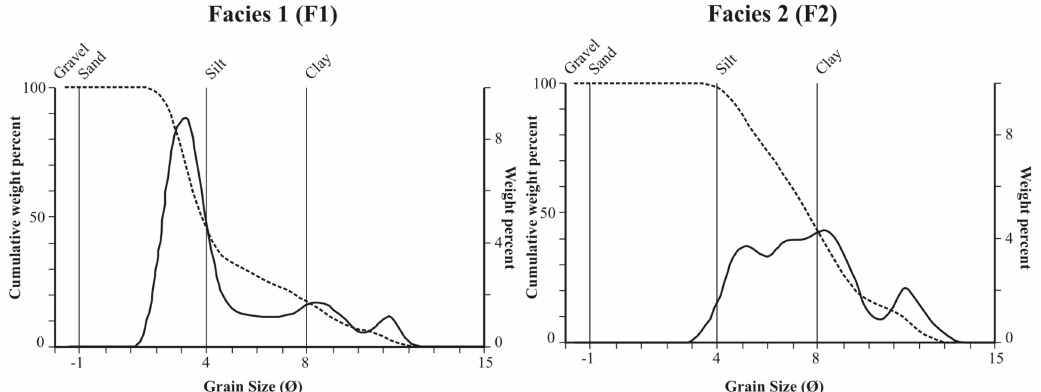
Figure 2. Typical granulometric distribution of the two main facies described in this work: Facies 1: sample + 57-20 / 9 (160 − 161 cm) of calcareous ooze ( F1 ); and Facies 2: + 57-20 / 9 (140–141 cm), lithogenous silt ( F2